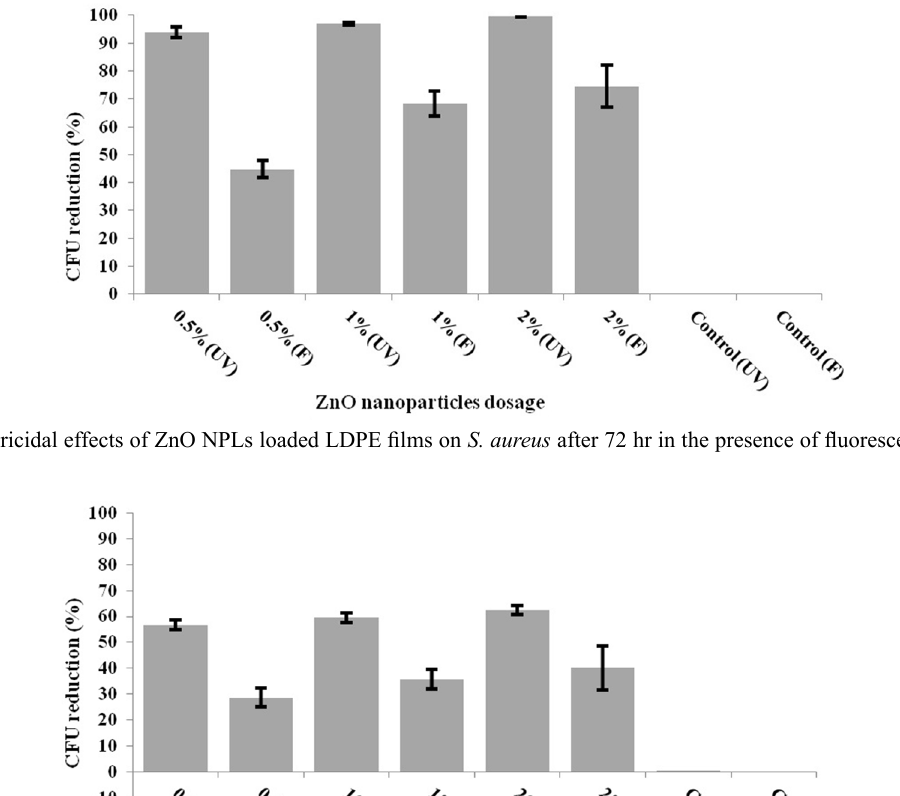
NPLs loaded LDPE films on S. aureus i n fresh calf minced meat after 72 hr in the presence of fluorescent Fig. 3. Bactericidal effects of TiO 2 and UV lights at 4 o C